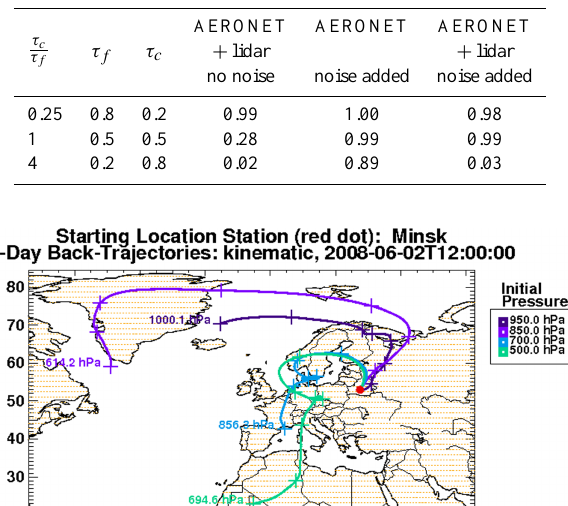
Table 3. Relative errors of spherical particle faction retrieval.